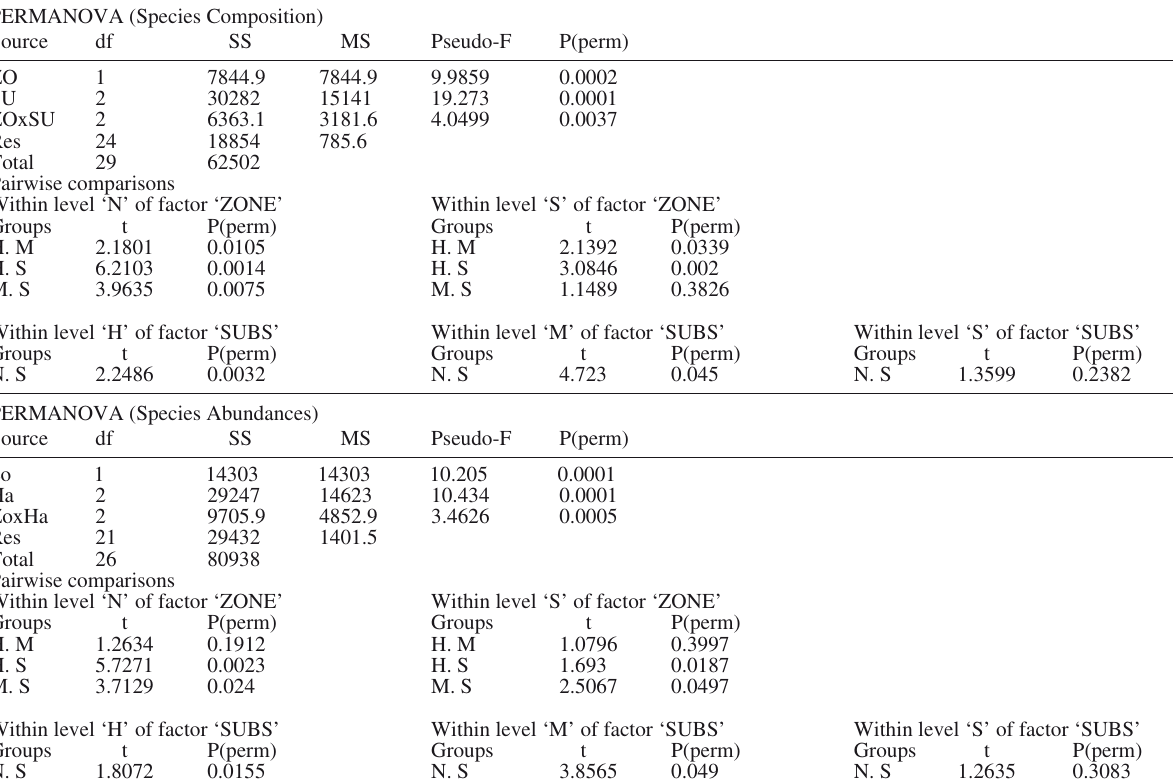
Within level ‘N’ of factor